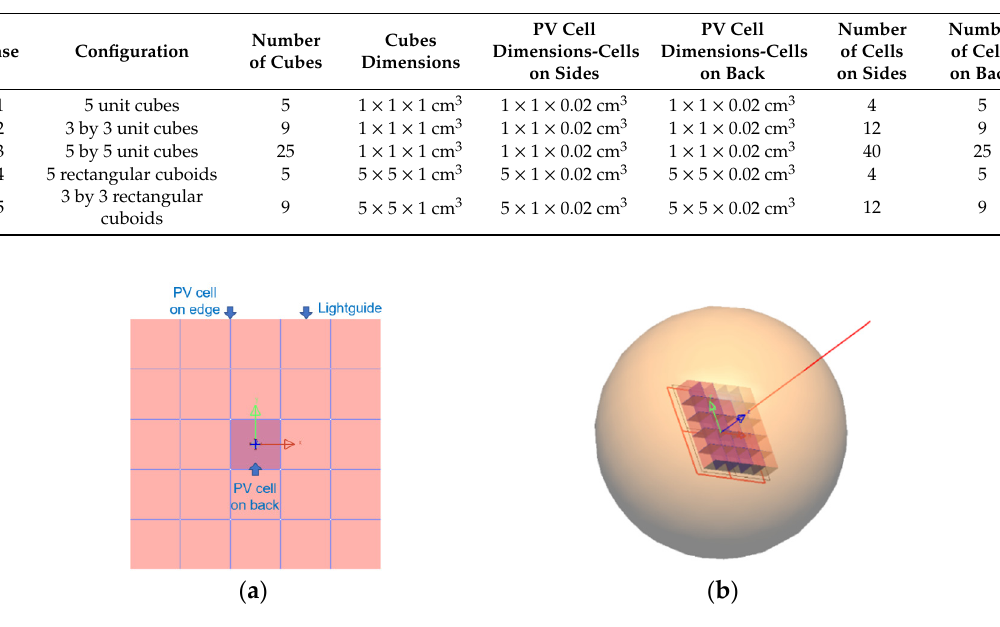
Figure 3. The geometry of the LSC PV device shown in Case 3 of Table 1: ( a ) top view of device; ( b ) the orange sphere shows the diffuse irradiance and the red line indicates the direction of the direct beam irradiance.